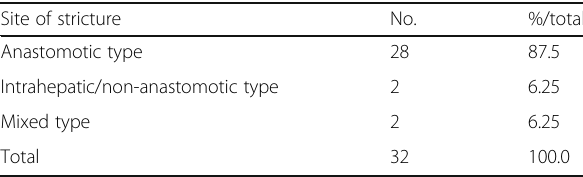
Table 2 Classification of the biliary strictures among our cases according to its site Site of stricture No. Anastomotic